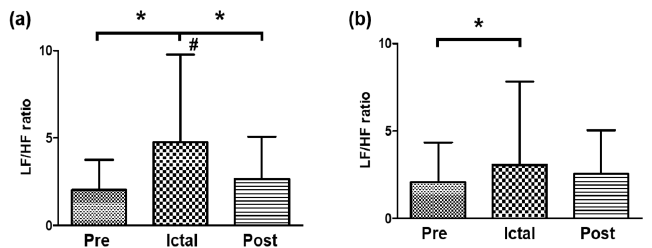
Figure 2. Comparison of the LF/HF ratio between intervals for the ( a ) FLE group and ( b ) TLE group. * Indicates significant different between intervals (pre-ictal, ictal, and post-ictal). # Indicates significant different between types (FLE and TLE) at same interval.